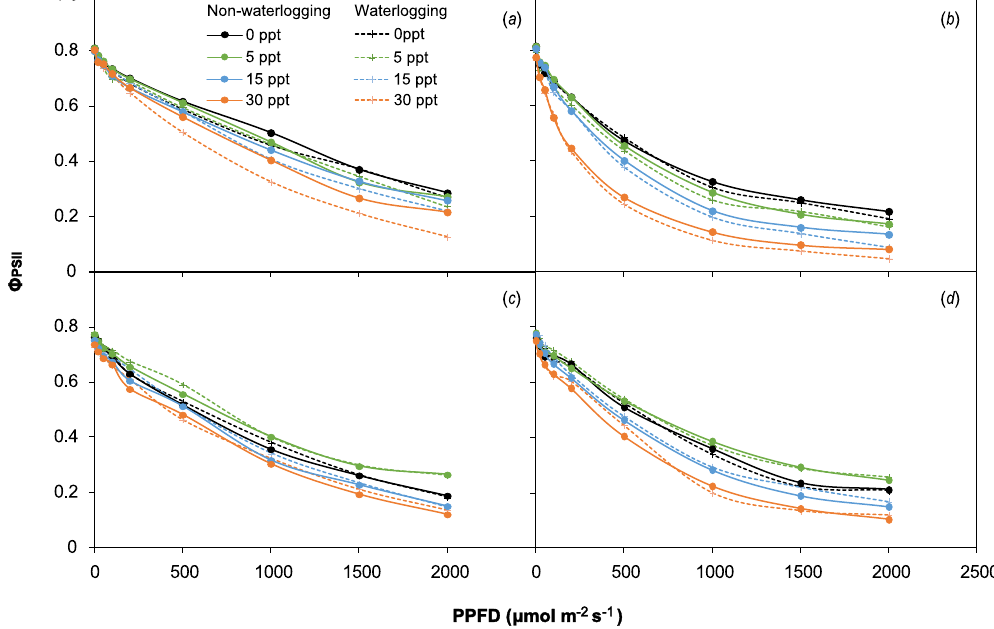
Figure 5. Instant quantum yield (PPFD-adapted) of photosystem II ( Φ PSII , only means presented) of P. australis ( a , b ) and S. alterniflora ( c , d ) under waterlogging and salinity treatments in the early and late growing seasons.